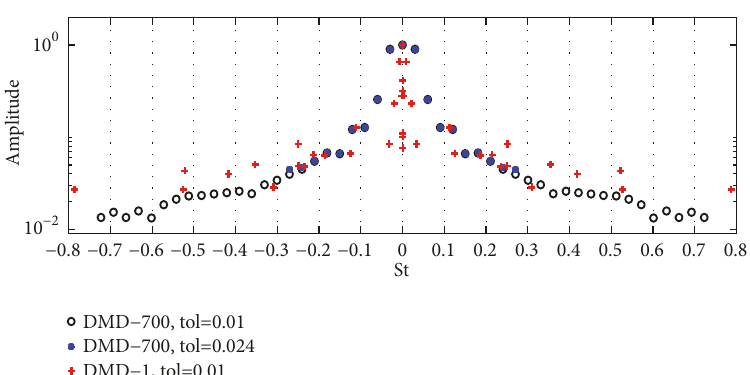
Figure 6: Amplitude versus St obtained for low accuracy via DMD-1 (red crosses) and DMD-700 (blue circles) and for high accuracy using DMD-700 (black circles).